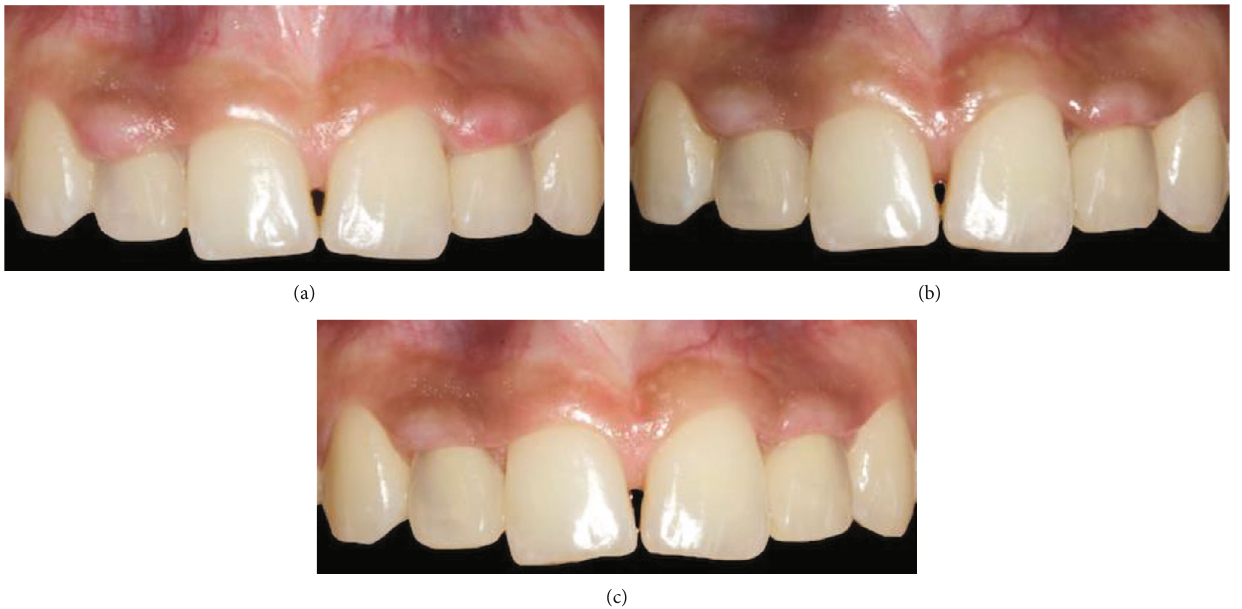
Figure 4: Peri-implant mucosa formation and gingival adaptation along with the emergence pro fi le of the crown restoration: adaptation phase. (a) Soft tissues at two weeks of follow-up receded in an apical position and appeared without in fl ammation. (b) Soft tissues at 1 month of follow-up were adapted along the emergence pro fi le of the crowns. (c) Soft tissues at 2 months of follow-up were stable, and the interdental spaces were completely fi lled by the interdental papillae.